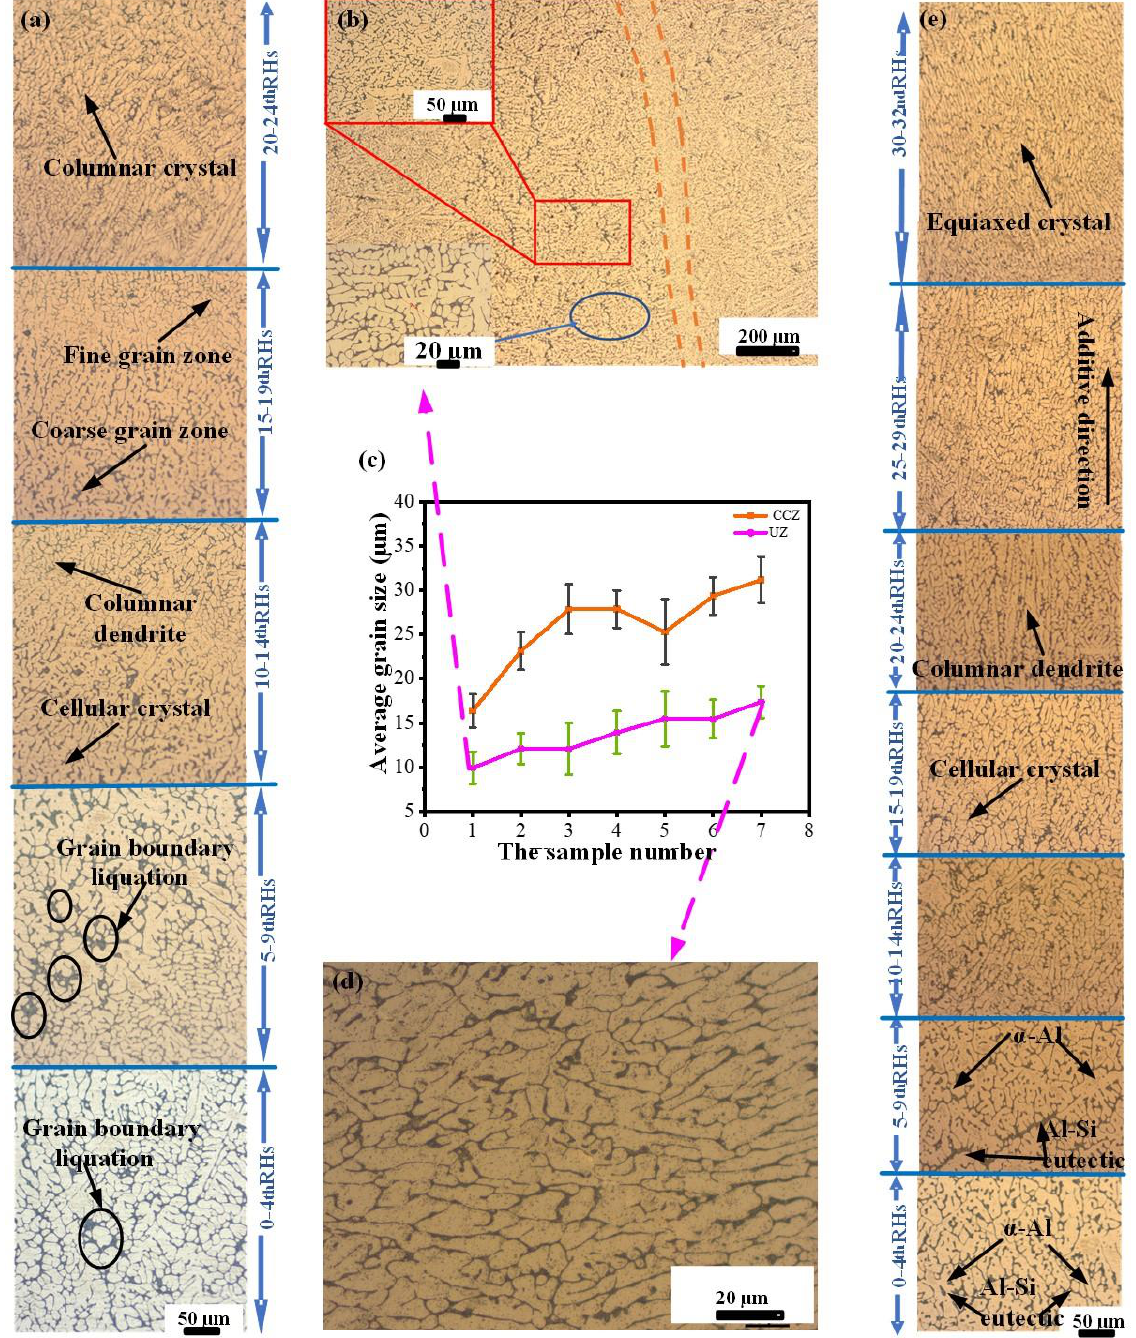
Figure 3. Microstructure of different regions of the metallographic pattern: ( a ) CCZ, ( b ) number 1 region of UZ, ( c ) average grain size of different regions, ( d ) number 7 region of UZ, and ( e ) UZ.